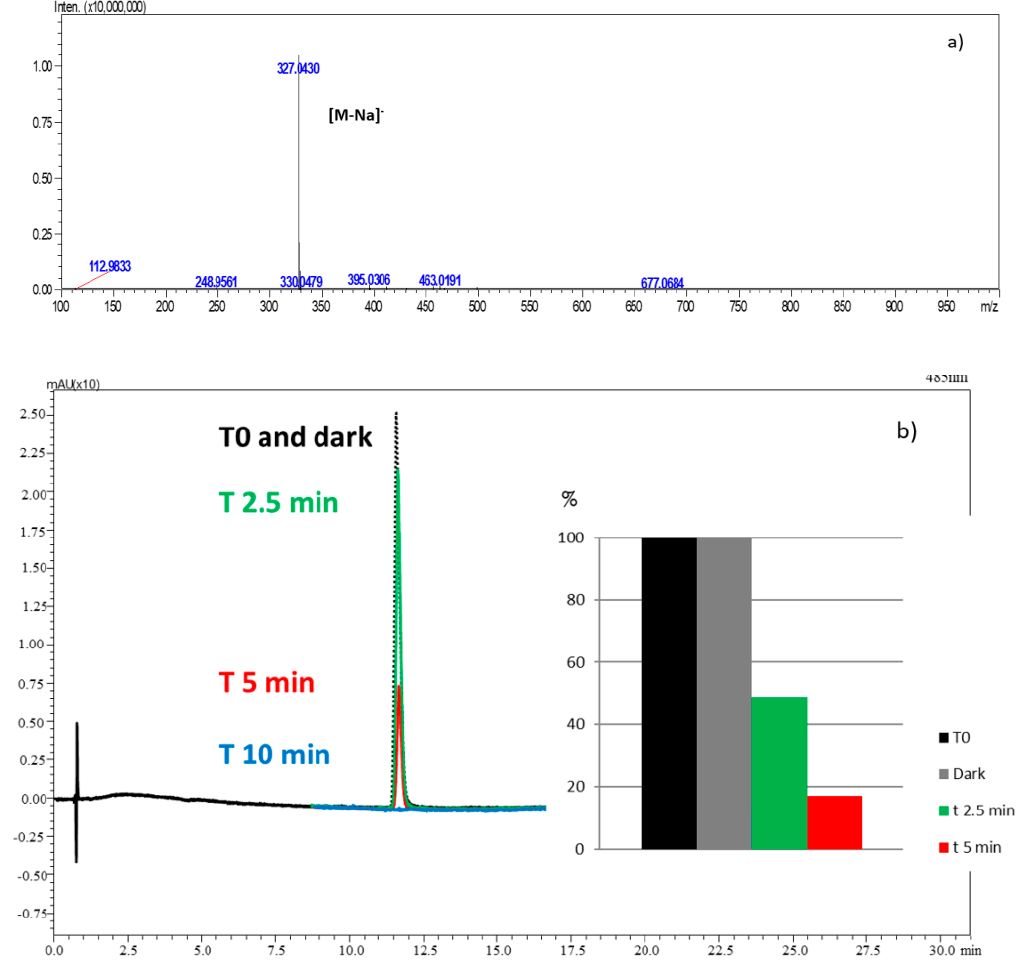
Figure 5. Mass spectra ( a ) and chromatographic profiles ( b ) of AO7 dye at 0; dark (adsorption); 2.5; and 5 min of run time in the presence of SF2 catalyst. AO7 initial concentration: 20 mg / L. Applied voltage: 12 kV. O 2 flow rate: 0.18 NL / min.